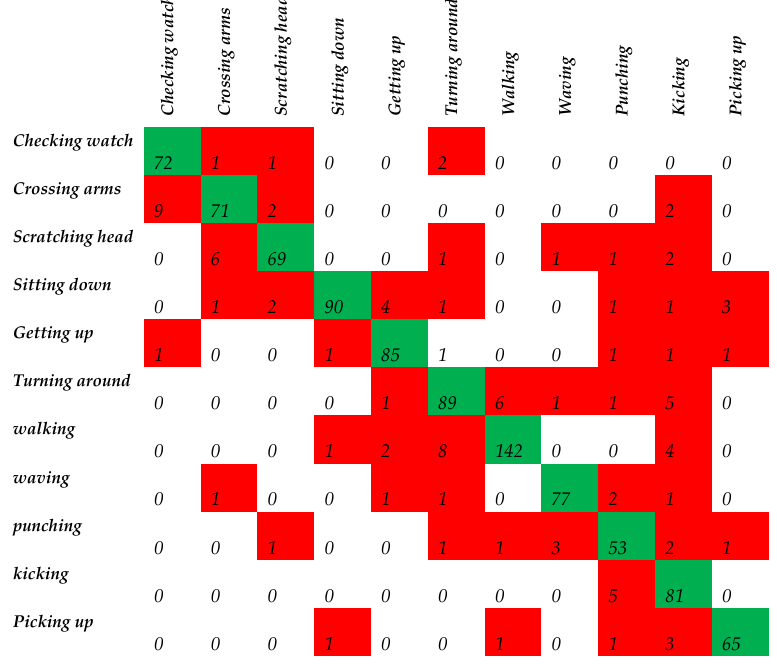
Figure 7. Confusion matrix of IXMAS (INRIA Xmas Motion Acquisition Sequences) dataset with 11 actions. Table 2. Comparison with state-of-the-art methods on IXMAS (INRIA Xmas Motion Acquisition Sequences)